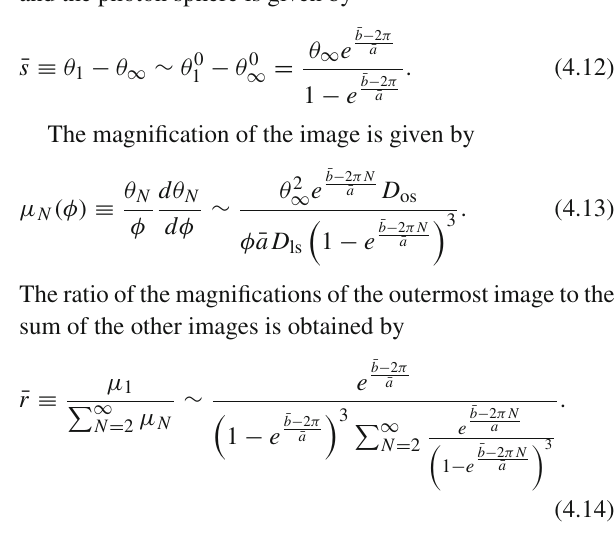
Fig. 3 Configuration of gravitational lensing. A ray with an impact parameter b is emitted by a source S with a source angle φ , it is reflected with an effective deflection angle ¯ α by a lens object L, and it is observed by an observer O as an image I with an image angle θ . D os , D ls , and D ol = D os − D ls denote distances between O and S, between L and S, and between O and L,